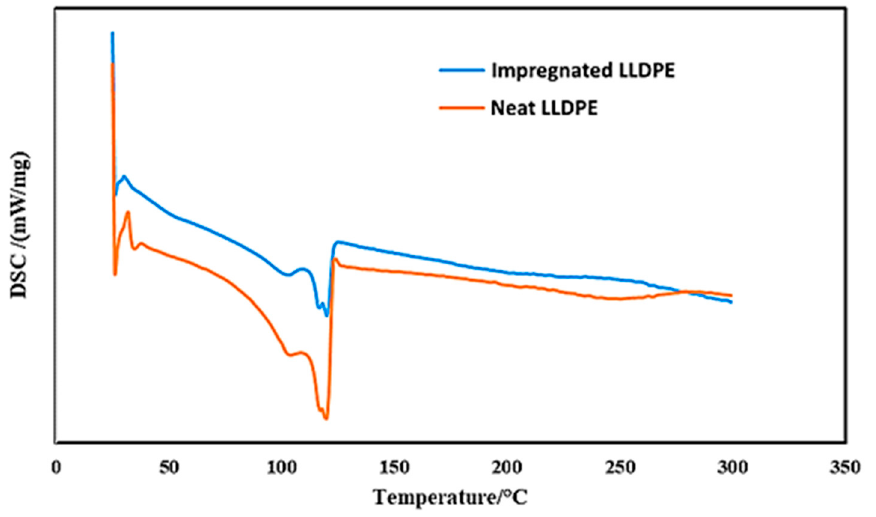
Figure 8. DSC spectra of the neat and impregnated LLDPE films.